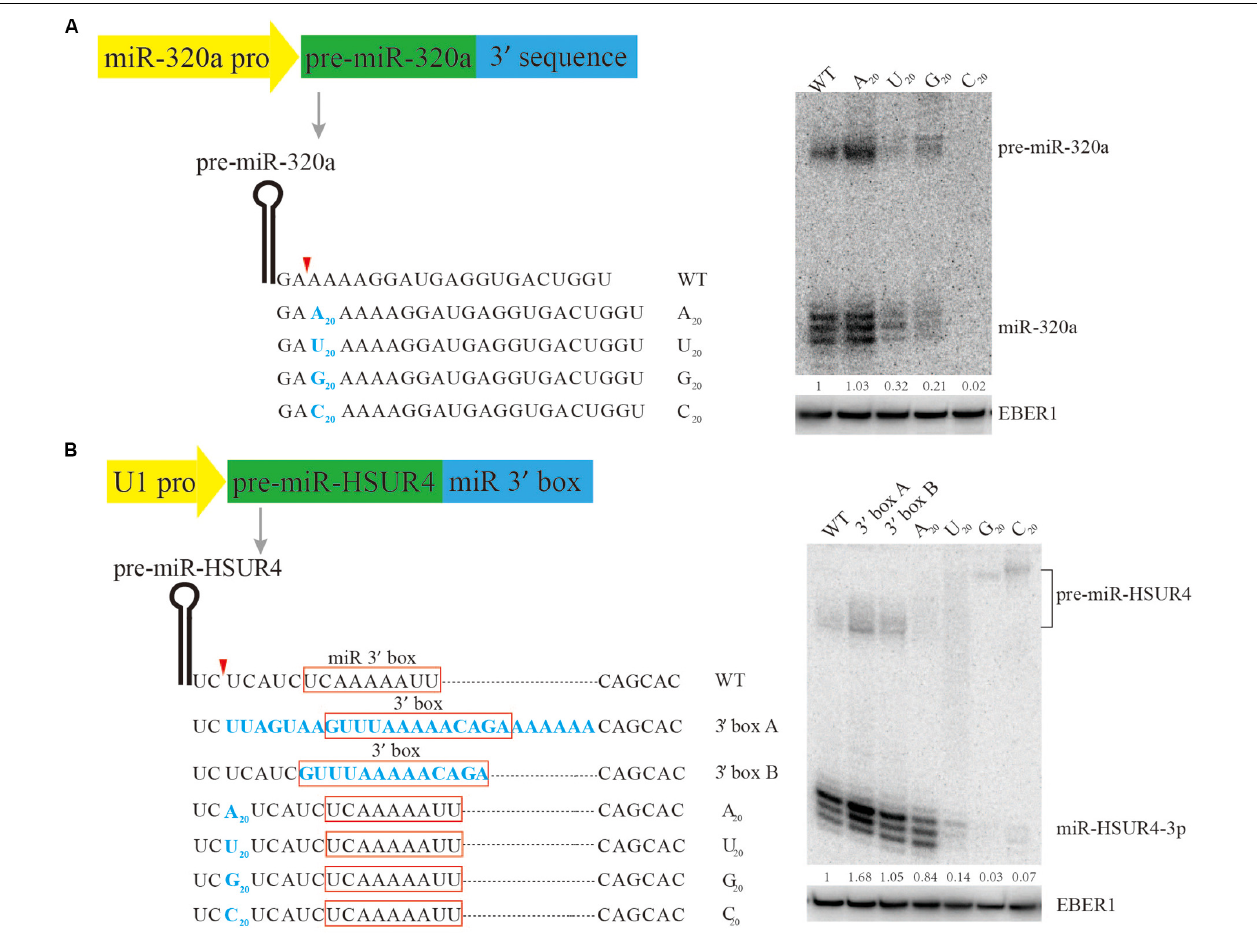
FIGURE 2 | Mutational analysis of the 3’ end formation signal for m 7 G-capped pre-miRNA. Serial mutations were made downstream of pre-miR-320a (A) and pre-miR-HSUR4 (B) . Northern blotting was used to analyze the siRNA produced from each construct when transfected in HEK293T cells. Red boxes indicate the 3’ box sequence of HSUR4 or the miR 3’ box sequence of pre-miR-HSUR4. EBER1 is an Epstein-Barr virus encoded Pol III transcript serving as a transfection and loading control. Quantitation of relative mature miRNA levels is derived from two independent